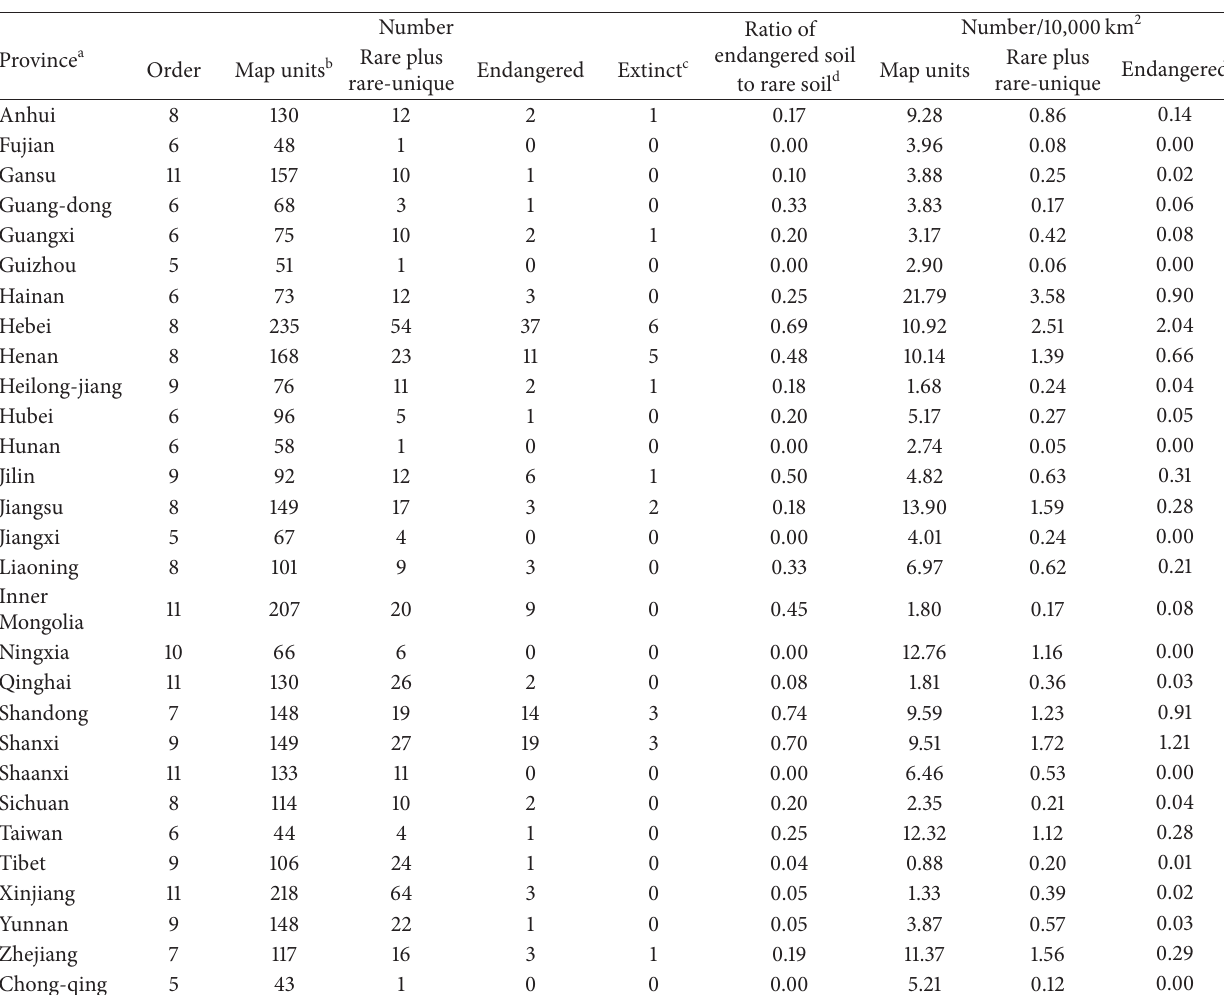
Table 3: (a) Soil diversity and rarity, by province, for China based on the 1,000,000 soil map of China [13]. (b) Number of endangered soils caused by cultivation and